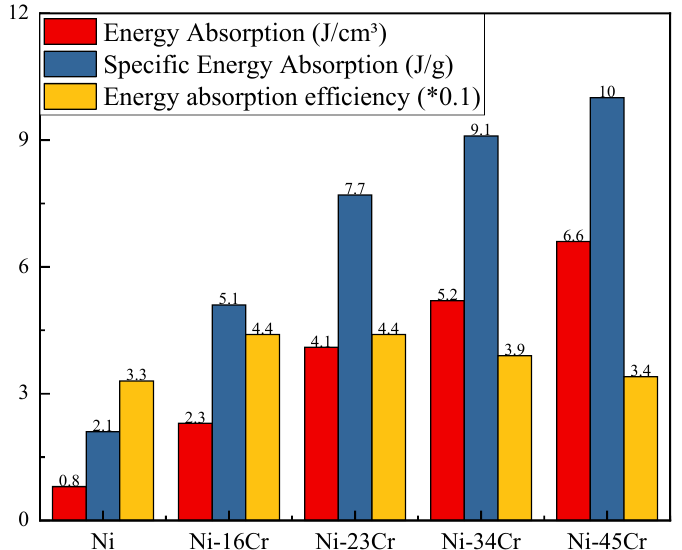
Figure 9. Energy absorption capacity of different NiCr alloys.